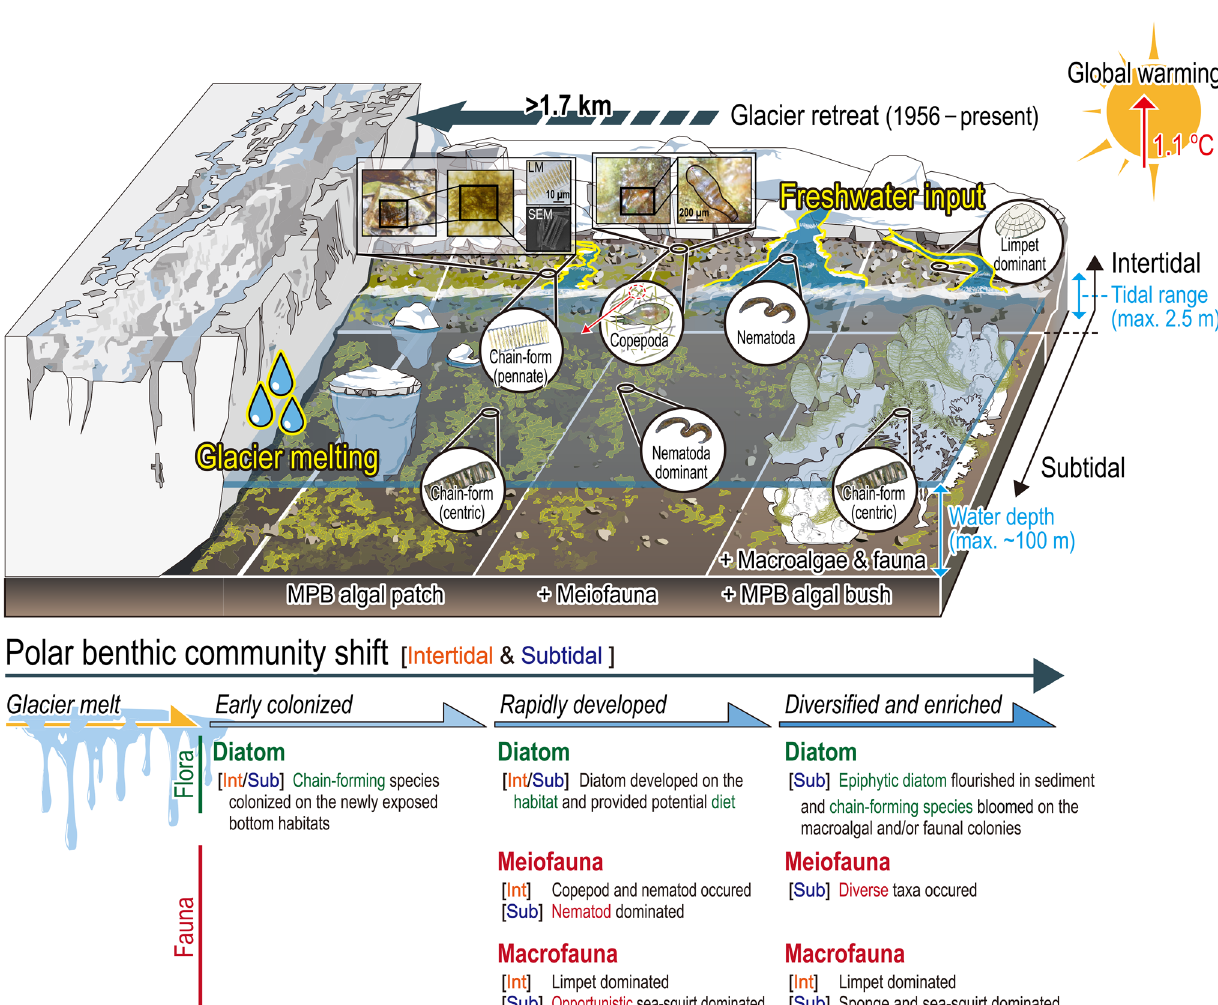
Figure 5. A schematic overview of the polar benthic community shift in an Antarctic cove under glacier retreat. This study and previous studies 5,10,30–33,35,37–41 were simultaneously analyzed and incorporated to delineate a simplified feature with three stages: (1) early colonized community, (2) rapidly developed community, and (3) diversified and enriched community along with distance from the